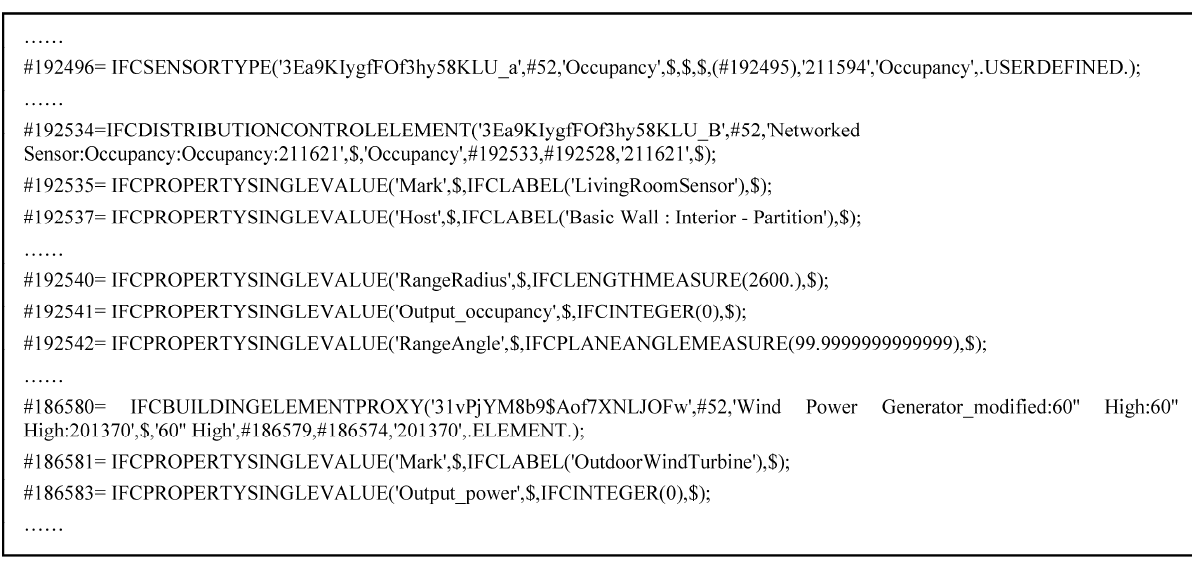
Figure 4. Code segment of the BIM IFC